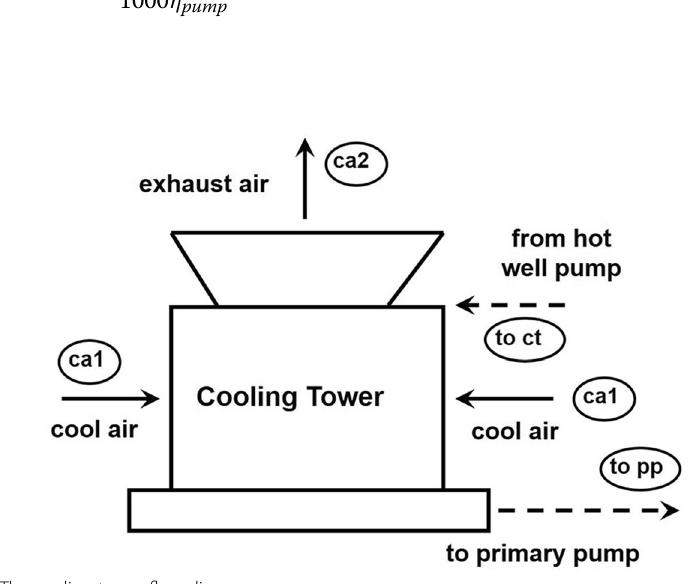
Fig. 11 The cooling tower flow